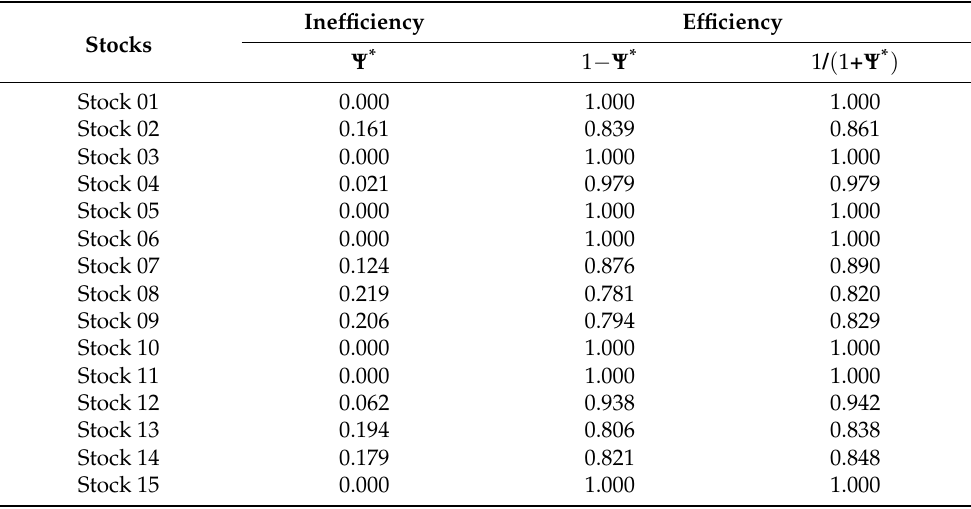
Table 4. The final results of the implementation of range directional measure model.